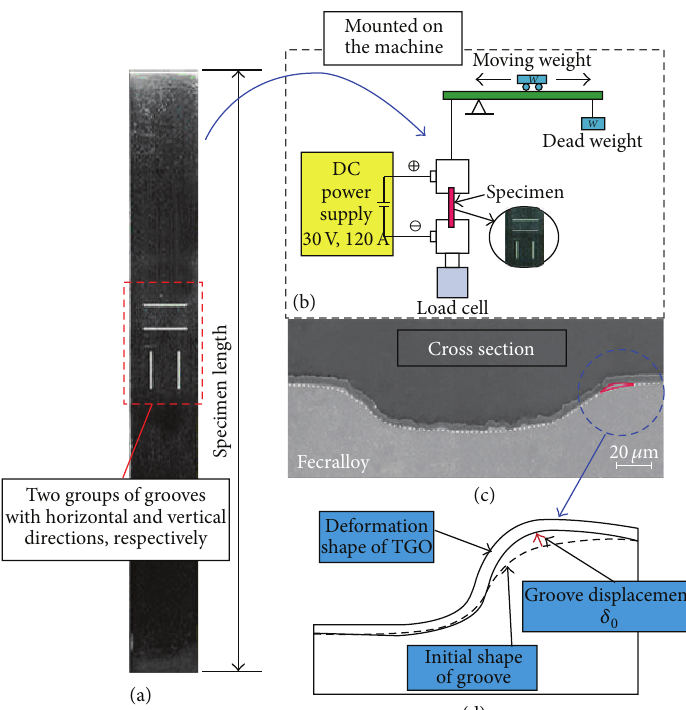
Figure 1: The experiment specimen geometry, test machine, and SEM for cross section showing deformation shape near groove. (a) Specimen geometry, (b) sketch for test machine, (c) SEM image for cross section, and (d) definition for the groove deformation.